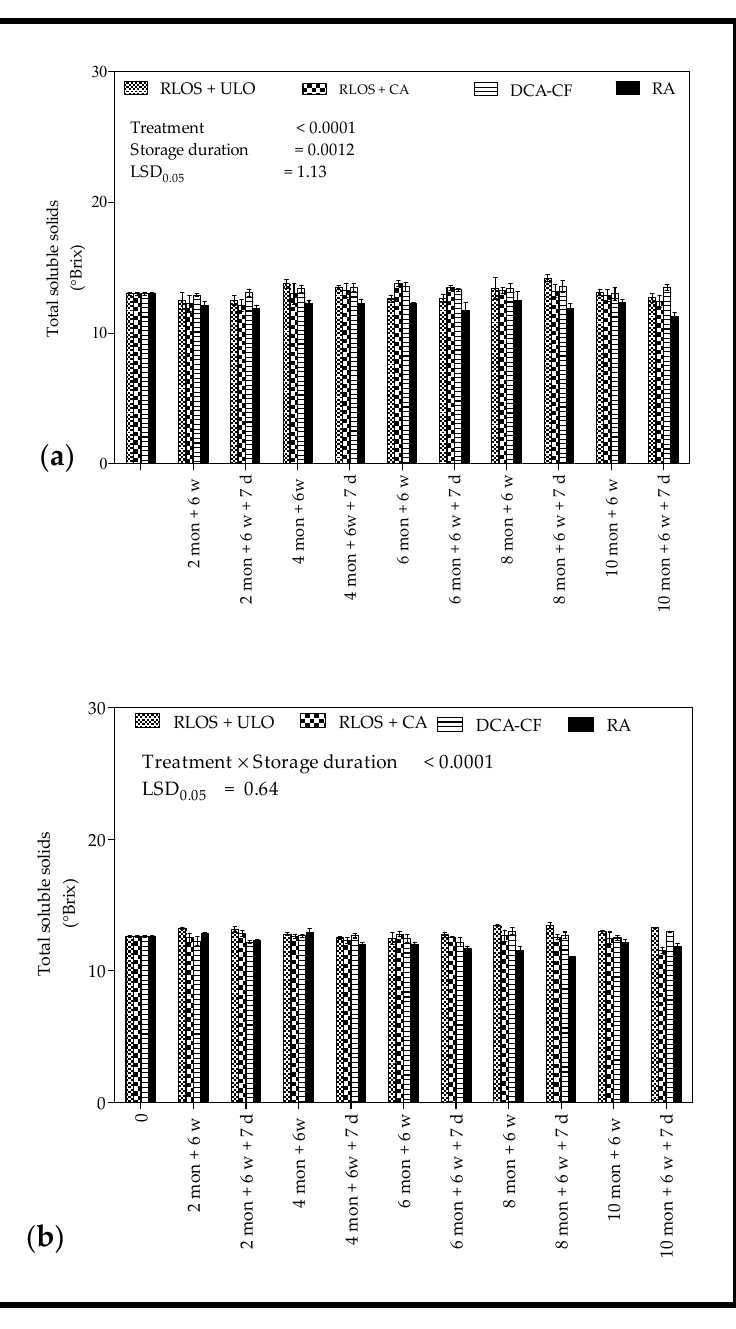
Figure 4. Total soluble solids (°Brix) of ‘Granny Smith’ apples harvested in the 2015 ( a ) and 2016 ( b ) seasons at commercial maturity and stored for up to 10 months at 0 °C in various storage conditions, evaluated every two months followed by a 6 week simulated shipment and handling period, and at 7 days on the shelf (20 °C and 65% RH). Vertical bars represent the standard error (SE) of mean values of 3 replicates (1 replicate = 10 fruit). LSD 0.05 represents least significant difference ( p < 0.05). For storage duration, mon—months; w—weeks; and d—days. RLOS—repeated low oxygen stress; ULO—ultra-low oxygen; CA—controlled atmosphere; DCA-CF—dynamic controlled atmosphere-chlorophyll fluorescence; RA—regular atmosphere.